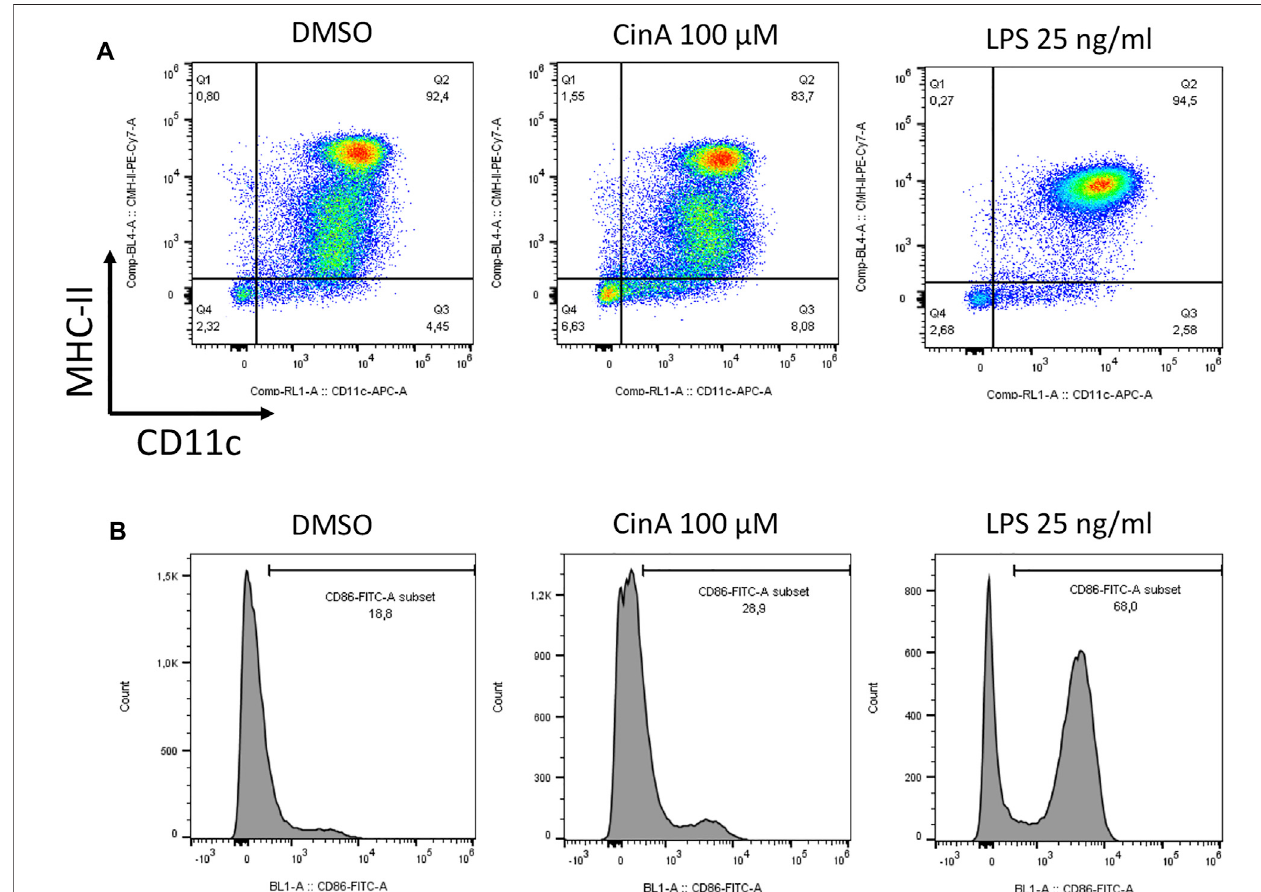
FIGURE 4 | BM-DCs were generated by culturing mouse progenitor cells in the presence of GM-CSF for seven to 8 days. Cells were then washed and stimulated or not (control) for 24 h with CinA (100 µM), or LPS (25 ng ml − 1 ) as a positive control of DC activation before being analyzed by fl ow cytometry for the expression of the following cell surface markers (A) CD11c and MHC-II, or (B) and CD86. Quadrant position and histogram gates were determined using isotype antibodies for each stimulation condition. Numbers in each quadrant/histogram gate represent cell percentages.